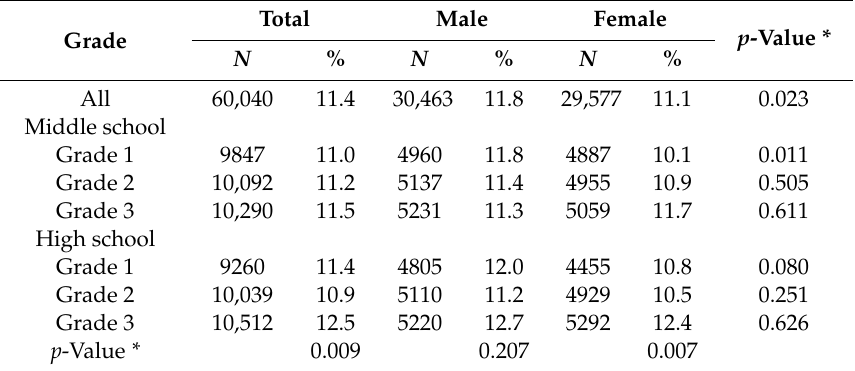
Table 2. Tooth fracture experience in the past 12